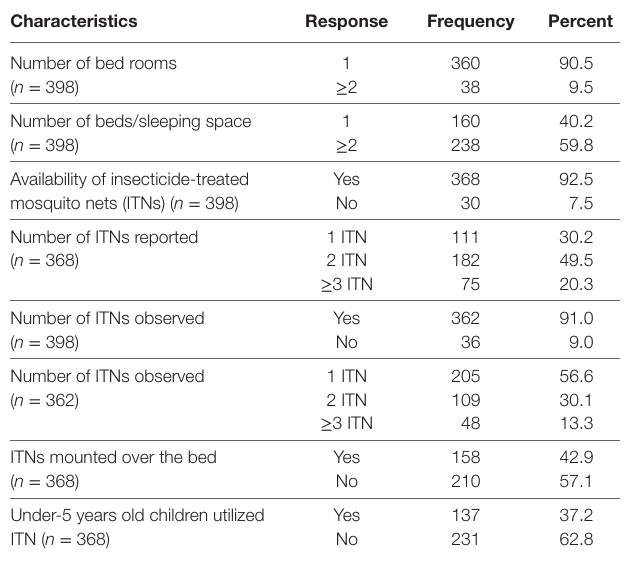
TaBle 2 | Intra-household characteristics of the households with under-5 years old children, Mirab Abaya district, Gamo Gofa Zone, Ethiopia, August–September,